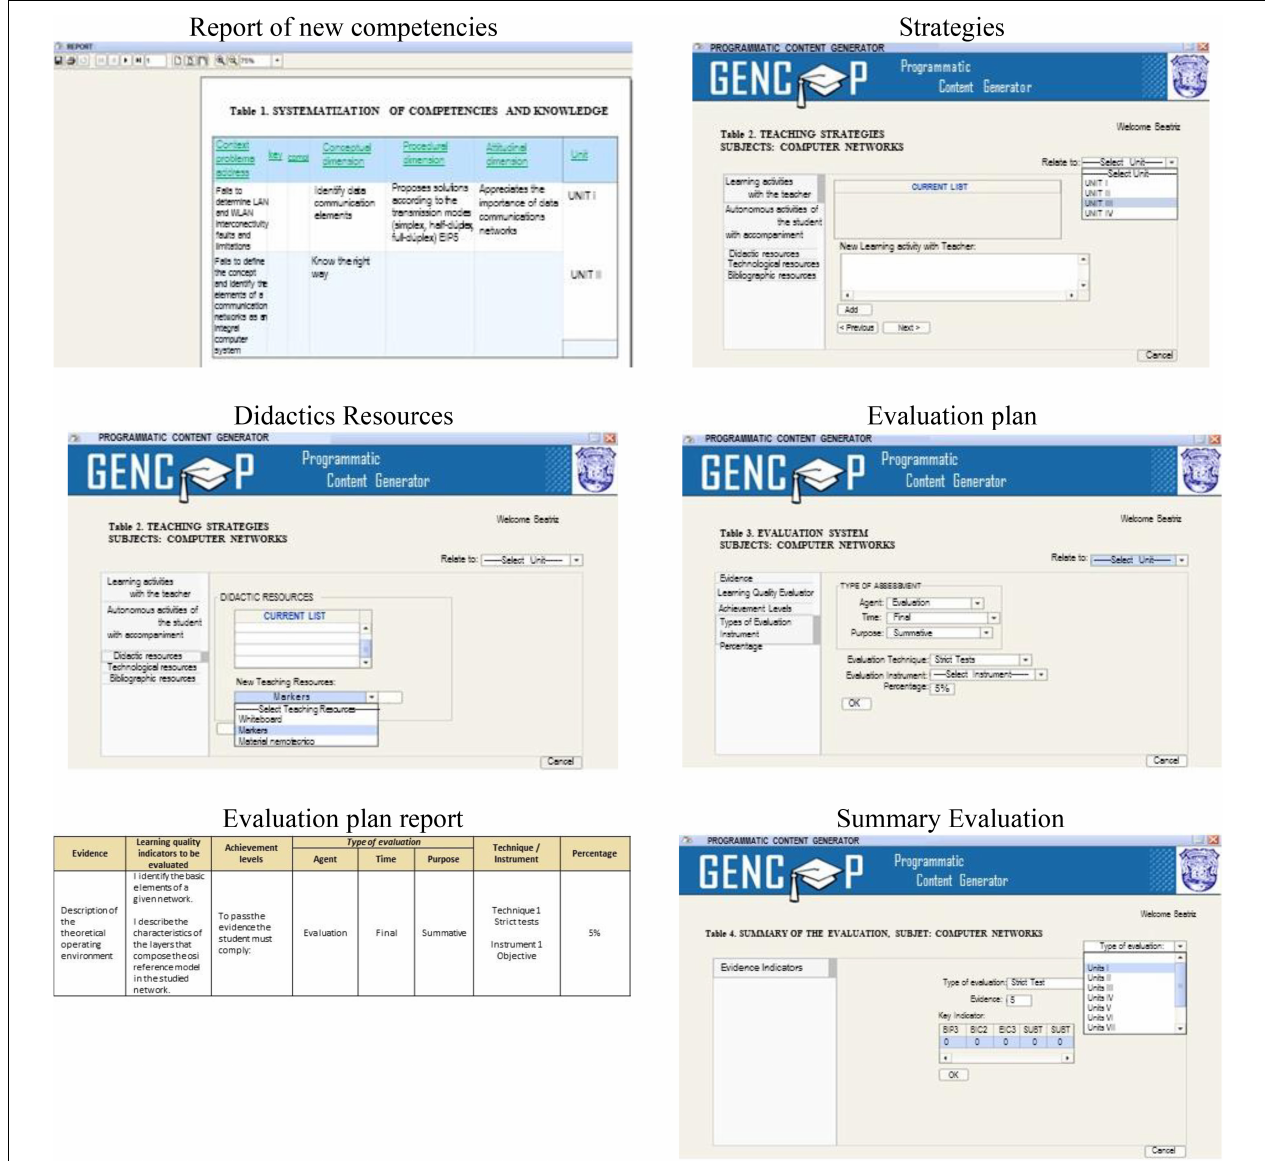
FIGURE 10 | Final prototype